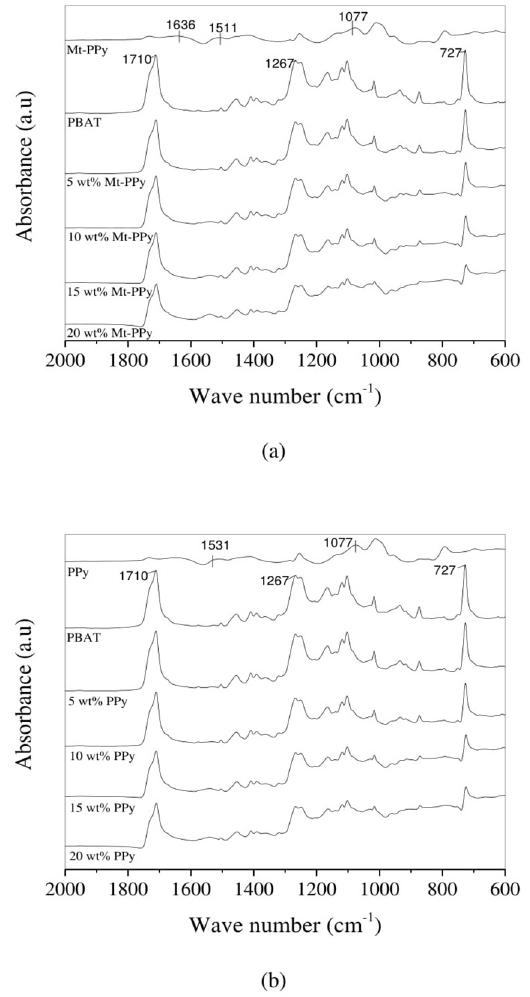
Figure 5. FTIR spectra of neat PBAT, PBAT/Mt-PPy and